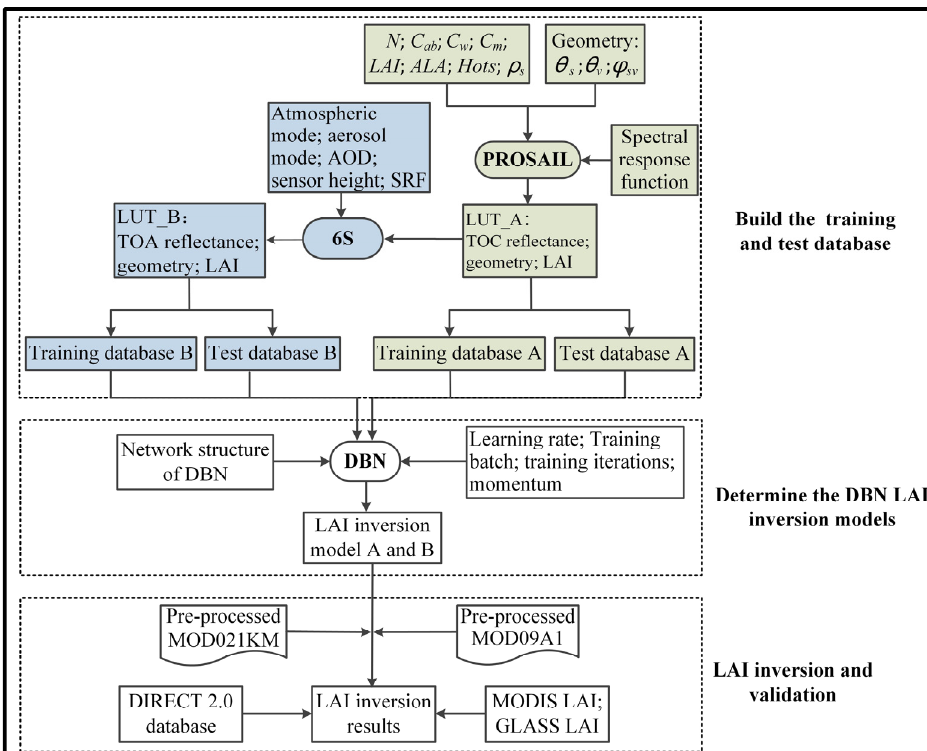
Figure 1. Flow chart of the LAI retrieval based on PROSAIL and the 6S coupling model. Among these, the portion with the green background represents the process of simulating the TOC reflectance LUT with the PROSAIL model, and the portion with blue background represents the process of simulating the TOA reflectance LUT with the 6S model on this basis. Model A is an LAI inversion model suitable for the TOC reflectance, and model B is suitable for the TOA reflectance.